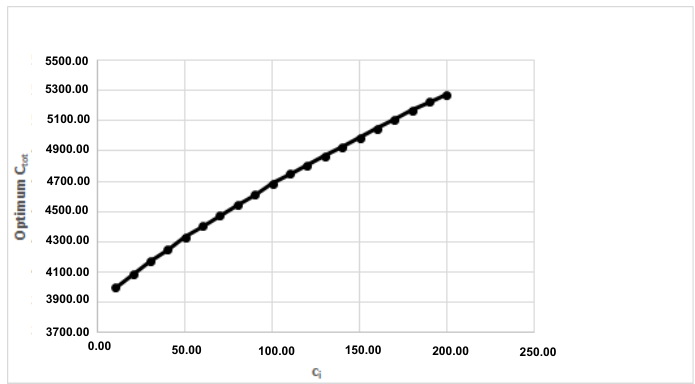
Figure 9. Variations of optimum C tot per c i